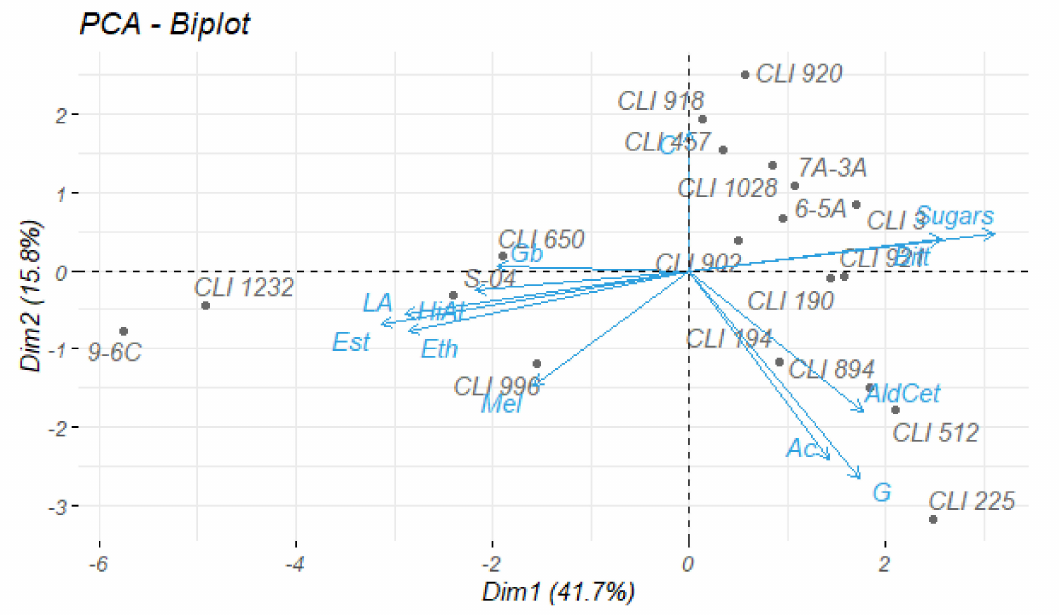
Figure 3. Projection of the beers on the axes formed by the principal components 1 and 2. Each object is the average of the three corresponding experimental beers. Eth, ethanol; LA, lactic acid; Bitt, bitterness; C, colour; HiAl, higher alcohols; Est, esters; Ac, acids; AldCet, aldehydes/ketones; Gb, γ -butyrolactone; G, guaiacol; Mel,